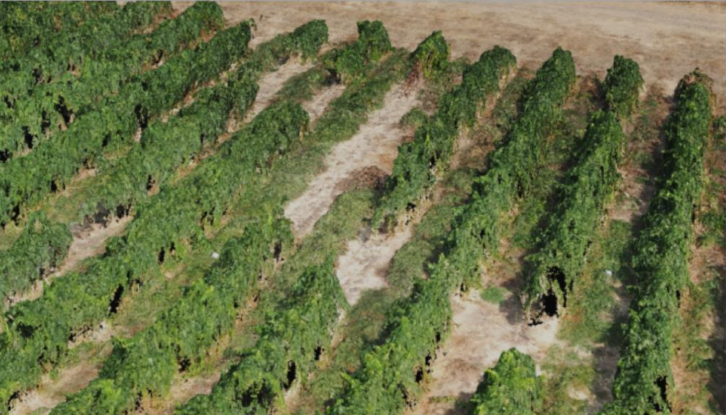
Figure 2. A partial view of the 3-D Point Cloud for the vineyard field A in July, which was produced by the photogrammetric processing of the remote images taken with the